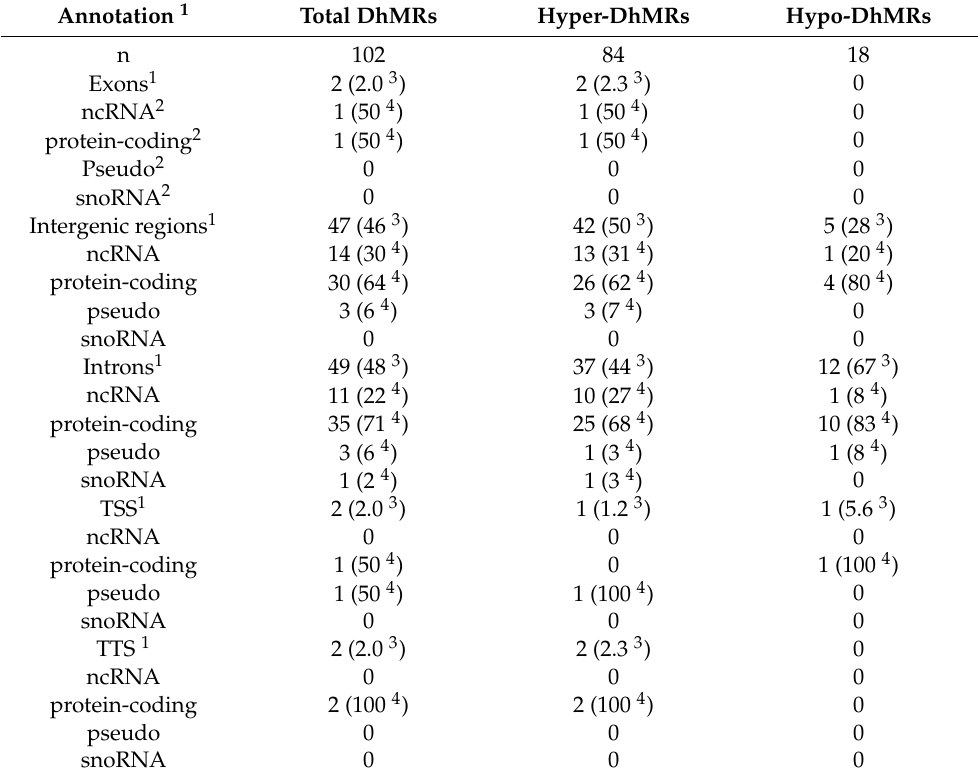
Table 1. Annotation of the nearest genes mapped to the 102 differentially hydroxymethylated